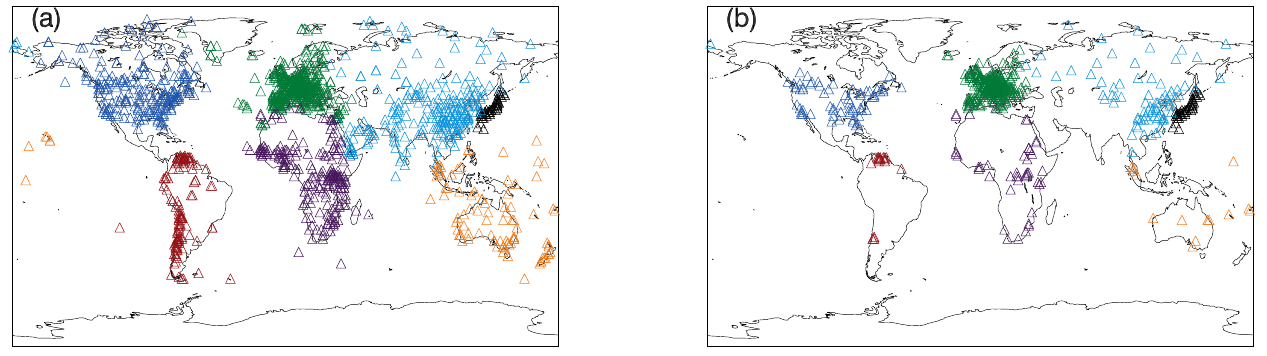
Fig. 12. Locations of the radiation measurement stations available in the GEBA dataset (a) and those used in our model-data comparison (b) . The different colours indicate the different regions in Fig. 13.